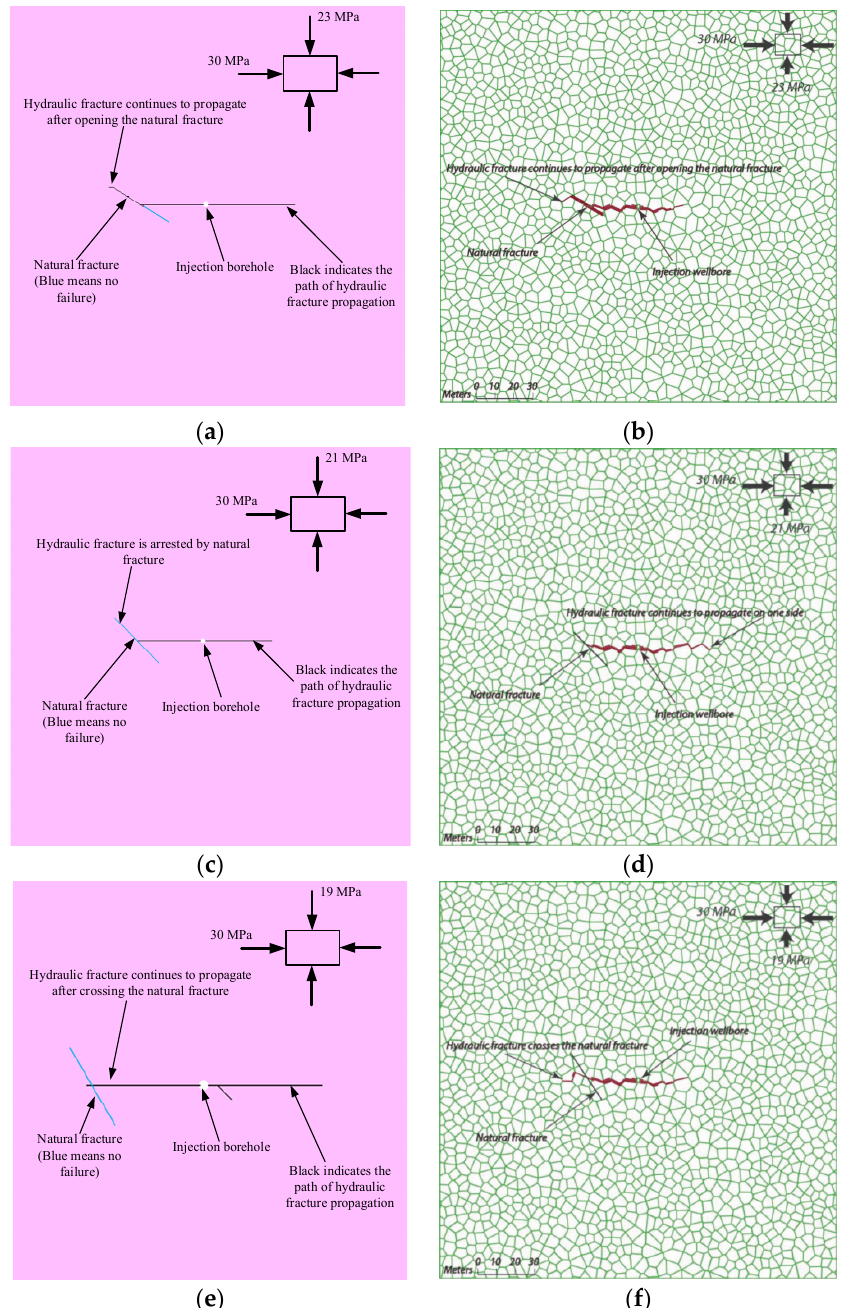
Figure 6. The comparison between simulation results of T-W modeling method (m = 100) and the simulation records of Zangeneh et al. [12]: ( a ) T-W modeling method simulation result at the approach angle of 30° when the differential stress is 7 MPa; ( b ) simulation result of Zangeneh et al. [12] at the approach angle of 30° when the differential stress is 7 MPa; ( c ) T-W modeling method simulation result at the approach angle of 45° when the differential stress is 9 MPa; ( d ) simulation result of Zangeneh et al. [12] at the approach angle of 45° when the differential stress is 9 MPa; ( e ) T-W modeling method simulation result at the approach angle of 60° when the differential stress is 11 MPa; ( f ) simulation result of Zangeneh et al. [12] at the approach angle of 60° when the differential stress is 11 MPa.